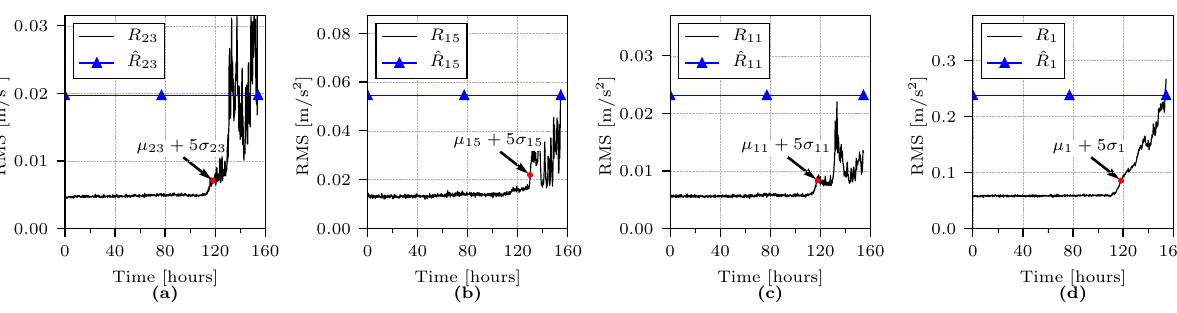
Figure 8: Collection of RMS trends with FTs for the in-house test rig dataset. (a) R [5600, 6000] Hz; (c) R